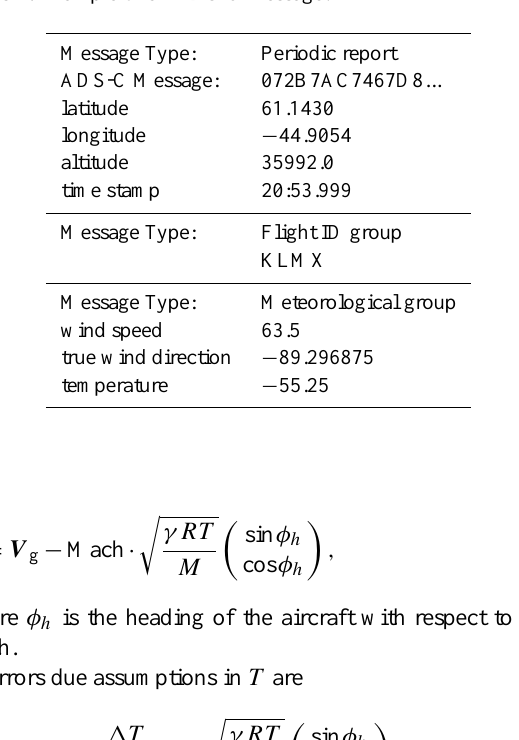
Table 2. Example of an ADS-C